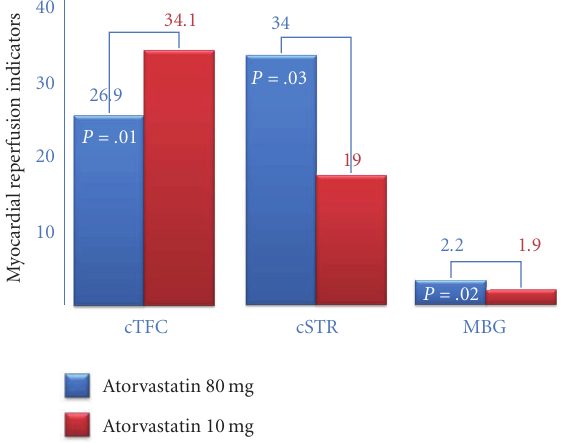
Figure 9: Statin-STEMI study. This modified graphic of the Statin- STEMI study, demonstrated the favorable e ff ect of high doses of atorvastatin before primary PCI on the Myocardial Reperfusion Indicators (cTFC, CSTR, and MBG) after procedure in individuals with